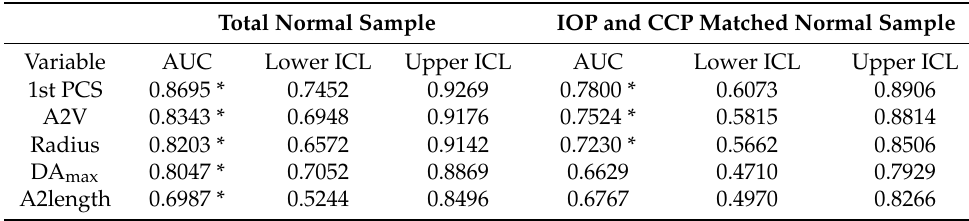
Figure 5. Receiver Operating Characteristic (ROC) curves for High Concavity Radius (red), second applanation length (purple), velocity (green) and maximum amplitude (blue). In black, the curve obtained with the first principal component score of the principal component analysis carried out with these four variables. The dashed line represents the x = y reference line. ( a ) curves obtained with the whole normal sample. ( b ) curves obtained with the IOP and CCP matched normal sample. Table 2. Area under de ROC curve (AUC) and upper and lower limits of the AUC 95% confidence interval for the different diagnosis parameters computed both with the entire normal sample and the IOP and CCP matched normal sample. DA max , maximum displacement amplitude, second applanation length (A2length) and corneal velocity (A2V), radius at high concavity (Radius) and the first principal component scores of the principal component analysis (1st PCS). ‘*’ marks AUCs significantly different from 0.5 (no discrimination).